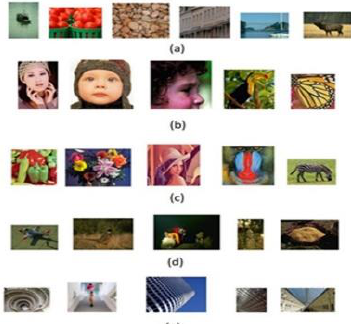
Figure 3. Some samples of the datasets used in our model: (a): dataset 291, (b): dataset SET5, (c): dataset SET14, (d): dataset B100, (e): dataset Urban